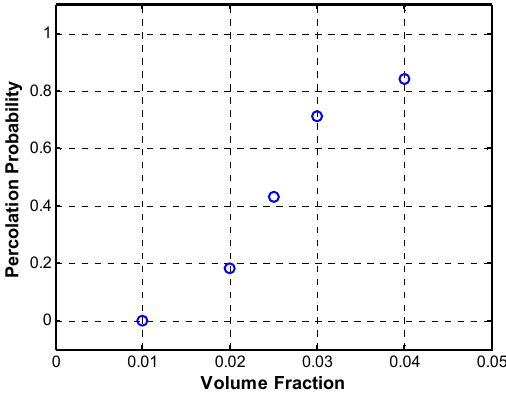
Figure 23. Percolation probability with length and diameter statistical distributions.